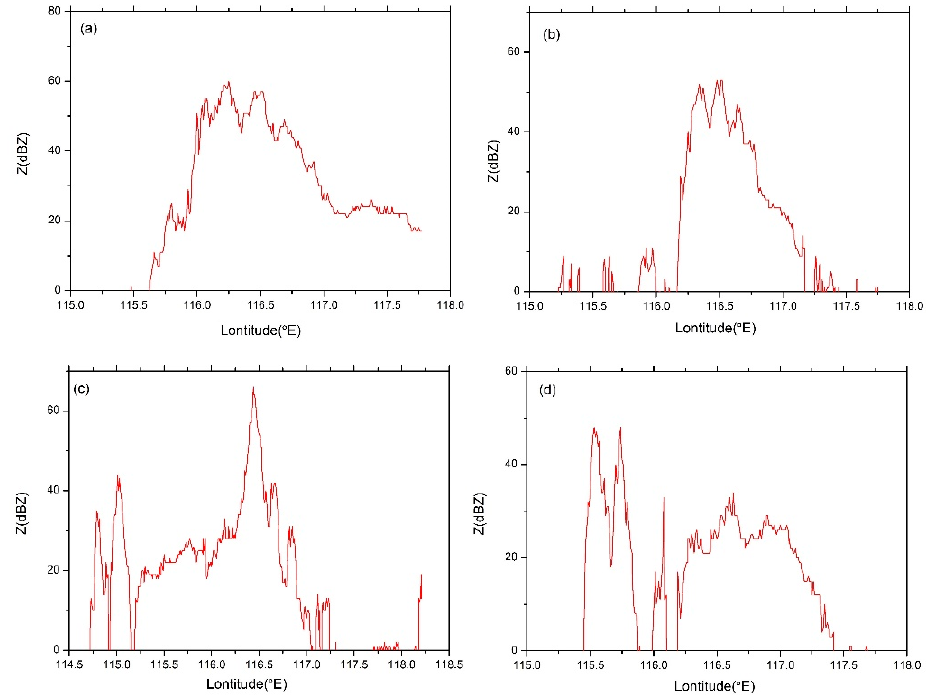
Figure 12. Radar reflectivity factor Z distribution along transects (40.5 ◦ N) crossing at the main core of the hailstorm in the longitudinal direction for the analyzed case studies. ( a ) Radar Z at 20:00 BJT on 25 June 2021; ( b ) radar Z at 16:00 BJT on 30 June 2021; ( c ) radar Z at 16:00 BJT on 1 July 2021; ( d ) radar Z at 17:00 BJT on 9 August 2021.